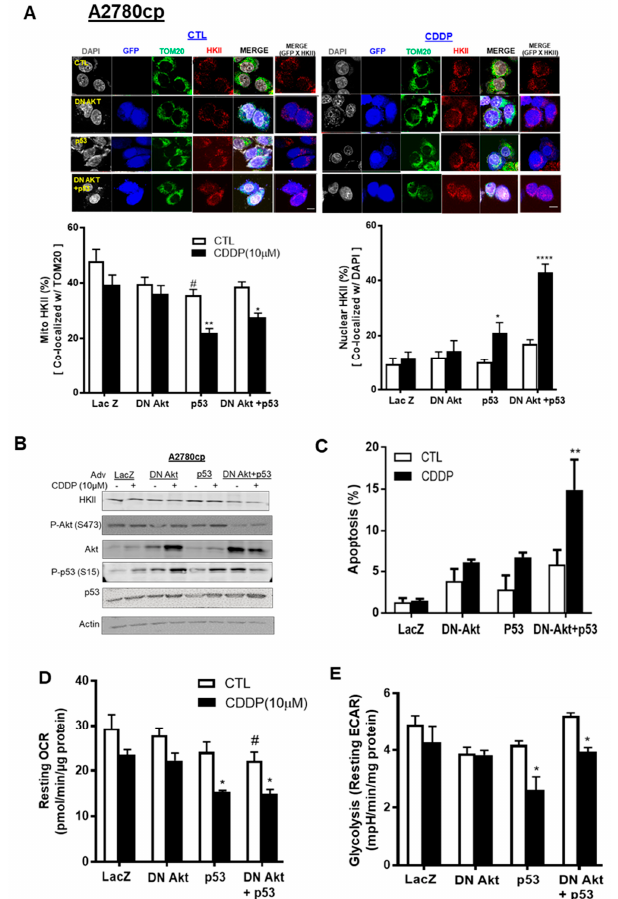
Figure 5. p53 reconstitution and Akt depletion together facilitate the detachment of HKII from the mitochondria. ( A ) A2780cp cells were transfected with either Adv–LacZ (MOI = 0.5 or 40; 12 h), Adv–p53 with GFP tag (MOI = 0.5; 12 h), or dominant negative (DN)-Akt Adv with GFP tag (MOI = 40), and cultured with CDDP (0–10 µ M; 24 h; DMSO as vehicle). Cellular localization of HKII (red) as % of total cells, p53/P-p53 with GFP tag (blue), TOM20 (Green), and DAPI (grey) was measured using confocal microscopy and quantified. ( B ) A2780cp cells transfected as above were cultured with CDDP (10 µ M; 24 h) followed by WB and ( C ) apoptosis measurement using Hoechst staining. ( D ) Oxygen consumption rate (OCR) and ( E ) glycolysis (resting ECAR) were measured in A2780cp cells infected with Adv–LacZ (MOI = 0.5 or 40.0; 24 h), Adv–p53 with GFP tag (MOI = 0.5; 12 h), or Adv–DN-Akt with GFP tag (MOI = 40; 12 h)—alone or together—seeded in 96-well plates, treated with CDDP (10 µ M; 24 h), and analyzed using an XF96e Extracellular Flux Analyzer. Scale bar: 10 µ m. Error bars denote ± SEM ( n = 5). (* p < 0.05, ** p < 0.01, **** p < 0.0001, CTL vs. CDDP; # p < 0.05, Adv–LacZ vs.